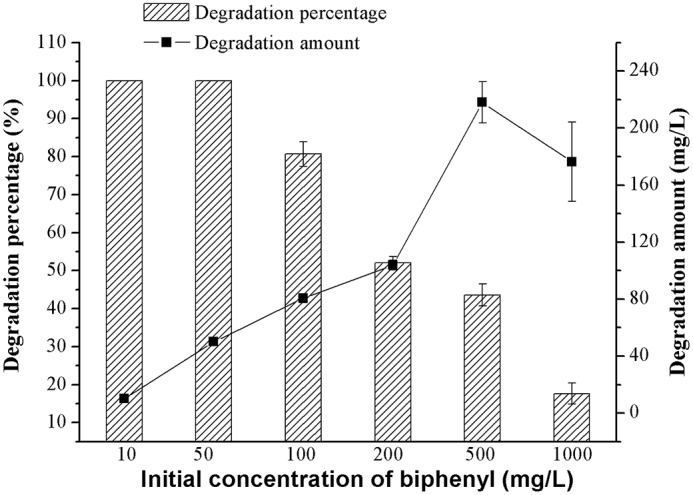
Degradation of various concentrations of biphenyl (10–1000 mg L−1) by HC3 in 24 hours.Inoculation amount was 10% (v/v). Error bars represent mean ± standard deviation (n = 3).